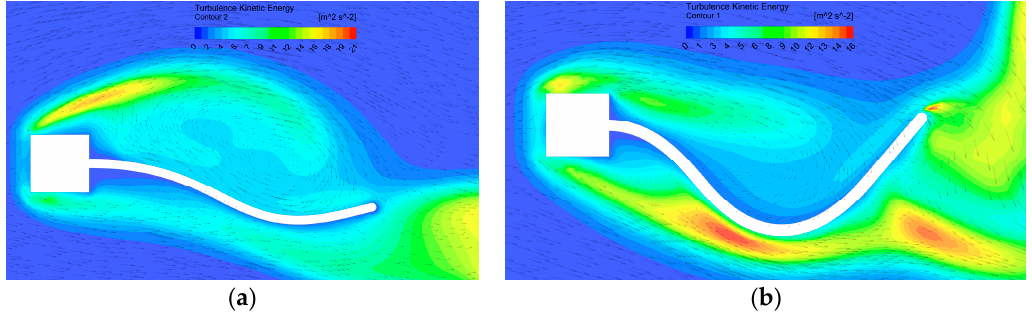
Figure 13. Turbulent kinetic energy contours (m 2 / s 2 ) and velocity vectors for higher strain energy shapes at u f = 14.3 m / s.: ( a ) D = 10 mm, RE = 9648; ( b ) D = 8 mm, RE = 7718.